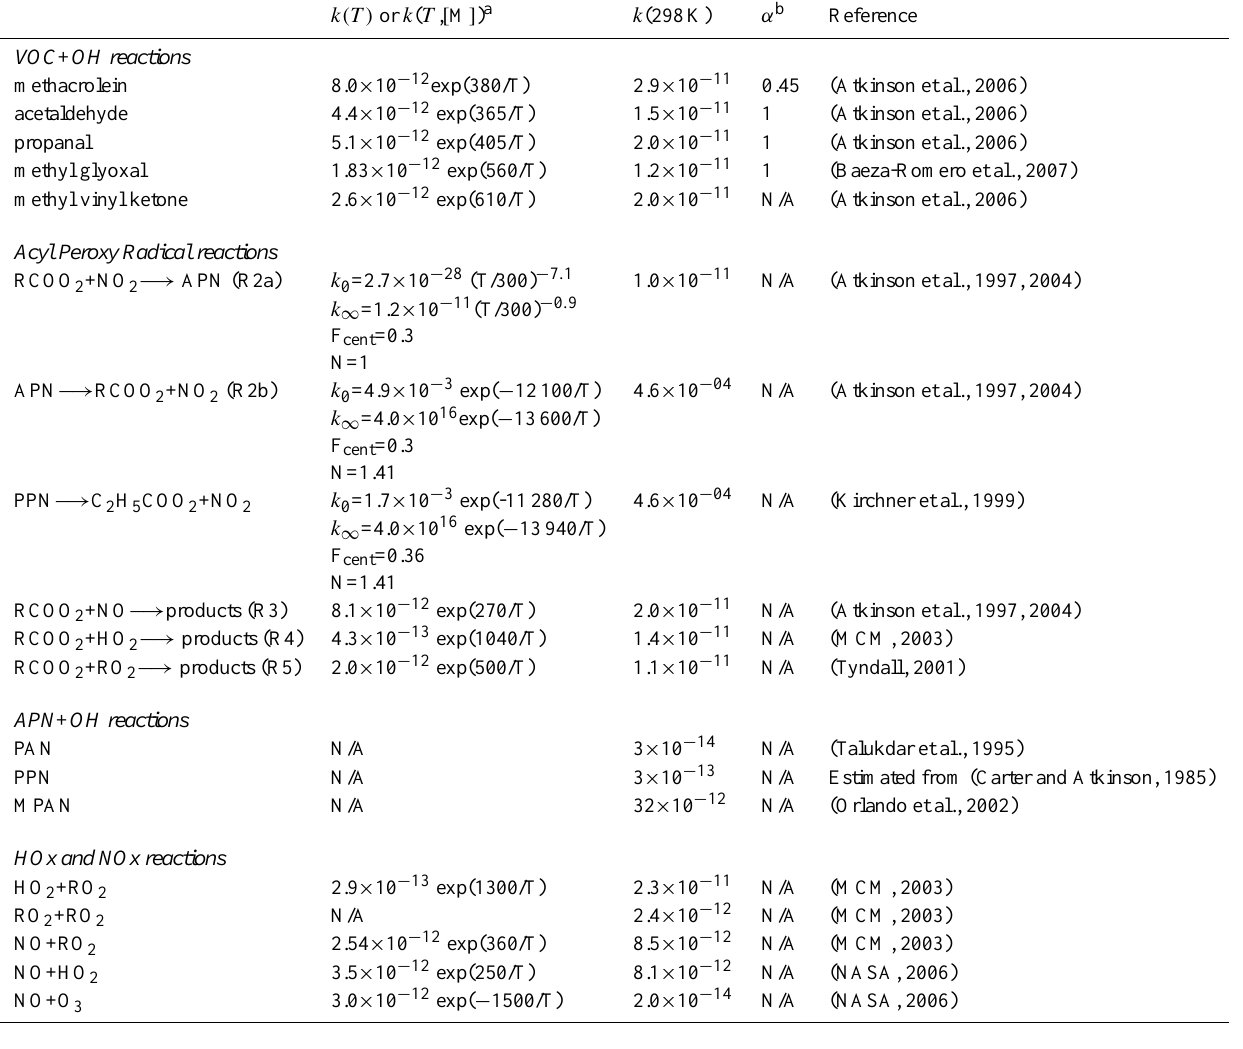
Table 1. Rate constants used in analysis.